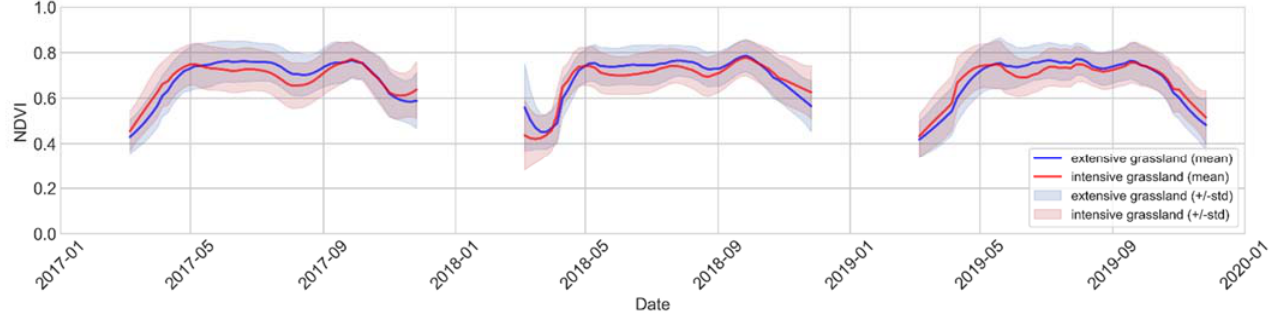
Figure 3. The mean temporal profiles and standard deviation range (+/ − std) of NDVI time series of intensive (red) and extensive (blue) grassland in Slovenia for the years 2017, 2018 and 2019.